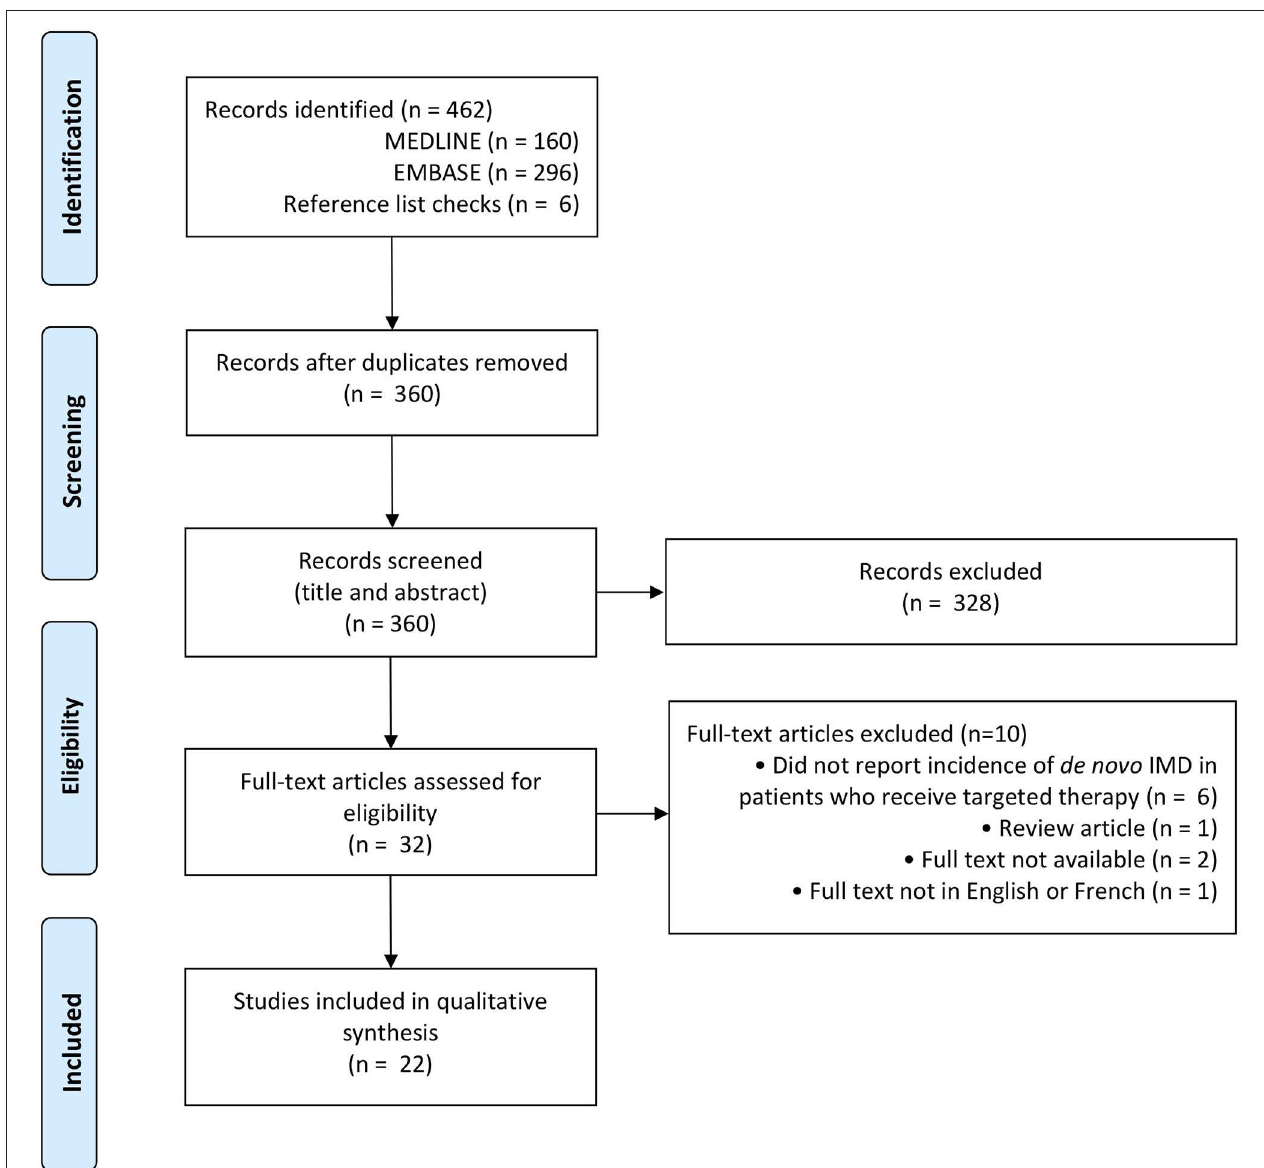
FIGURE 1 | PRISMA flow diagram for IMD incidence with targeted therapy